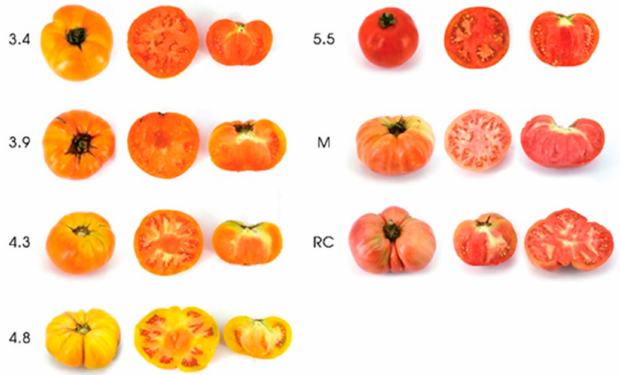
Figure 2. Fruits from the breeding lines (3.4, 3.9, 4.3, 4.8, 5.5), the original Mando landrace (M), and